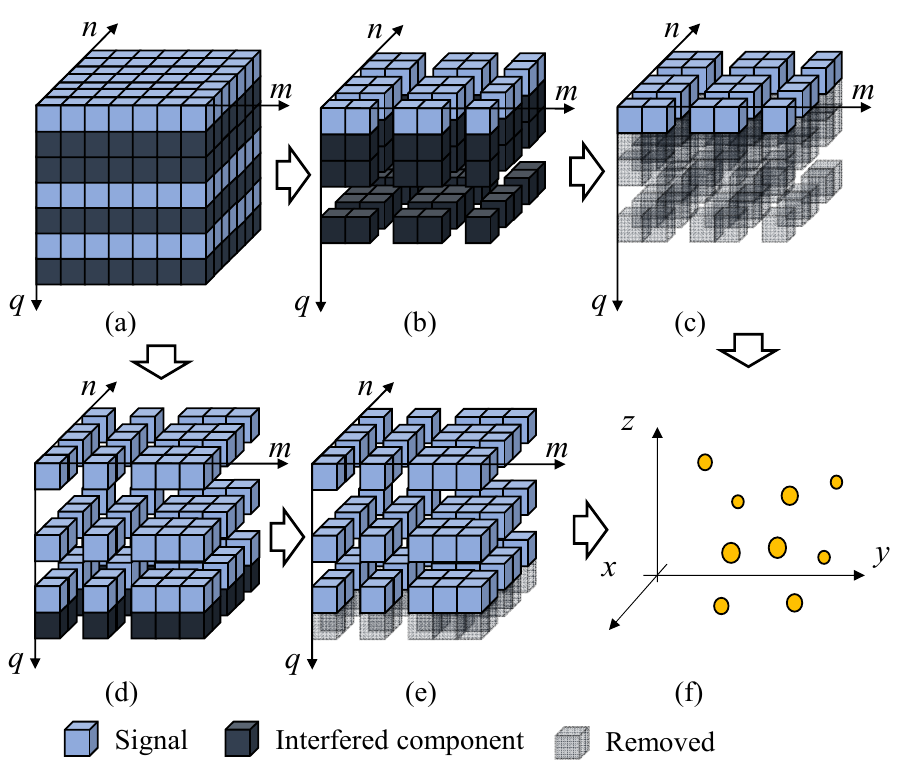
Figure 5. The schematic diagram that shows the advantage of CSS over RSS and the basic idea of the proposed cognitive sparse imaging method. ( a ) The structure of the 3D signal cube in (14), ( b ) the structure of the 3D signal cube in (15) obtained by RSS, ( c ) the structure of the 3D signal cube obtained by RSS and unusable block removal, ( d ) the structure of the 3D signal cube in (15) obtained by CSS, ( e ) the structure of the 3D signal cube obtained by CSS and unusable block removal, and ( f ) the 3D high-resolution target image obtained by exploiting the target sparsity.